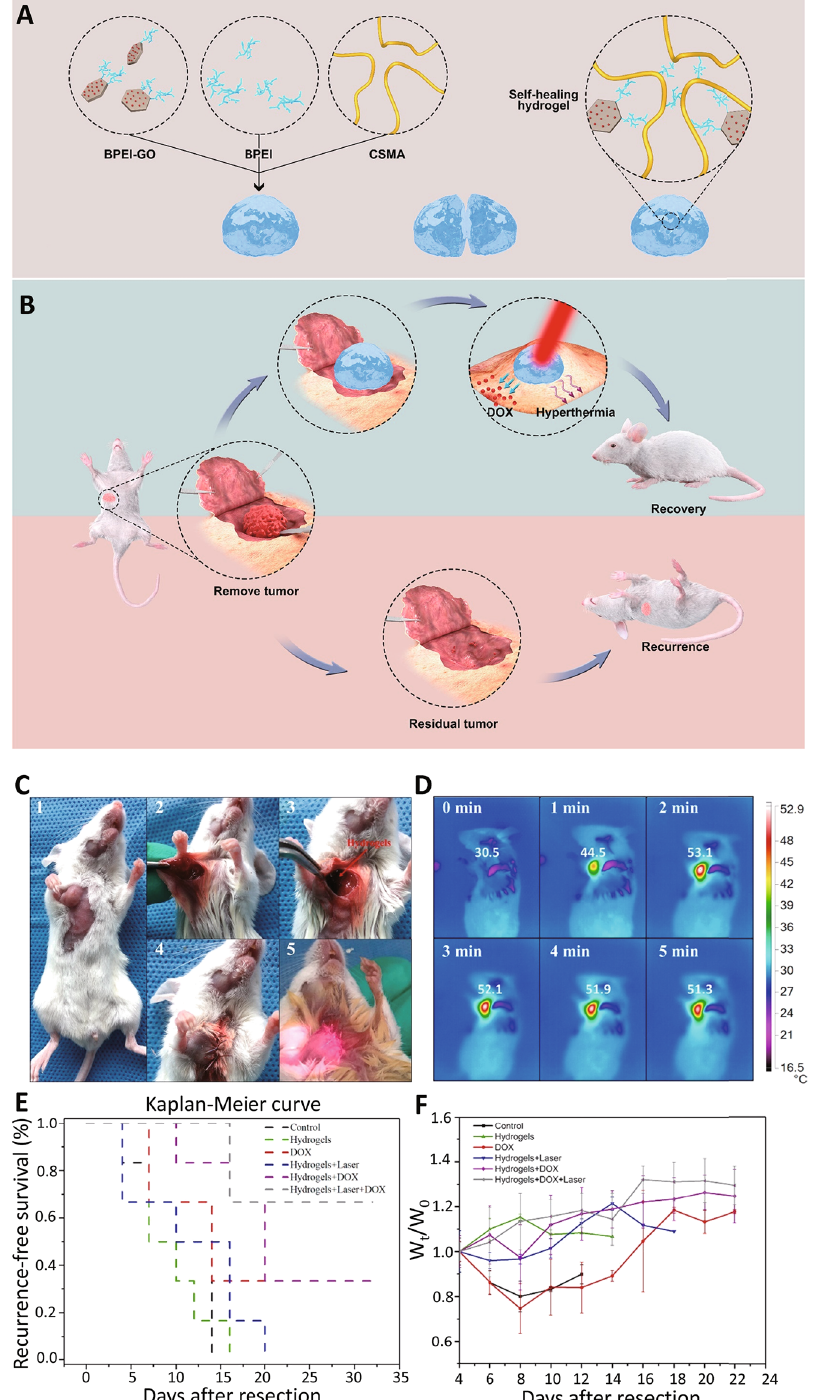
Fig. 10 A , B Preparative process of CSMA/BPEI/BPEI hydrogels and their applications in targeted anticancer drug delivery and photother- mal therapy of breast cancer. C Surgical procedure of tumor elimination and treatment: (1) the tumor volume was 200 mm 3 ; (2) the tumor was removed; (3) hydrogel was entrenched; (4) incision was sewed; (5) mice were illuminated with near-infrared laser after 1 day. D Near-infrared imaging of mouse entrenched with hydrogels. E Kaplan–Meier survival curve plotting tumor recurrence. F Body weight difference throughout treatment. Reproduced with permission from Ref. [116]. Copyright 2019 American Chemical